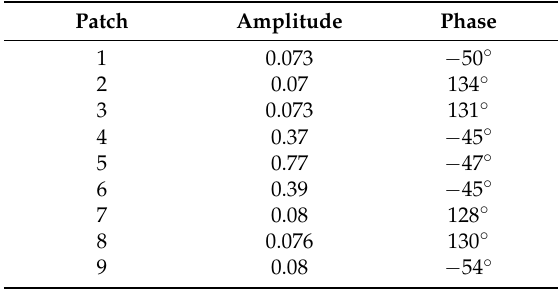
Figure 9. Amplitude and phase distribution of the array feed networks (AFNs). Table 1. Array Feed Network–Simulated Amplitude and Phase (5.8 GHz).